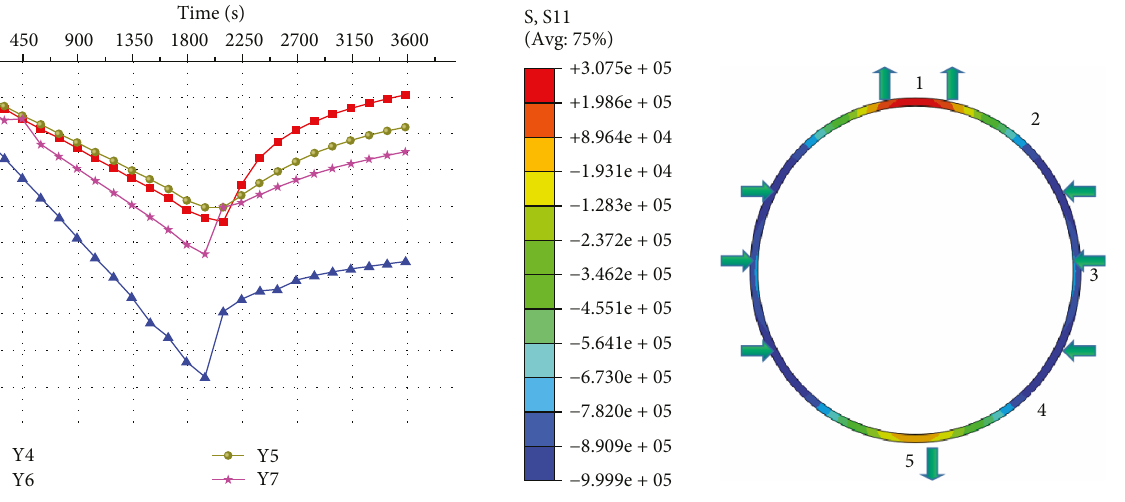
Figure 20: Surrounding rock pressure – time curves of Y4, Y5, Y6, and Y7.